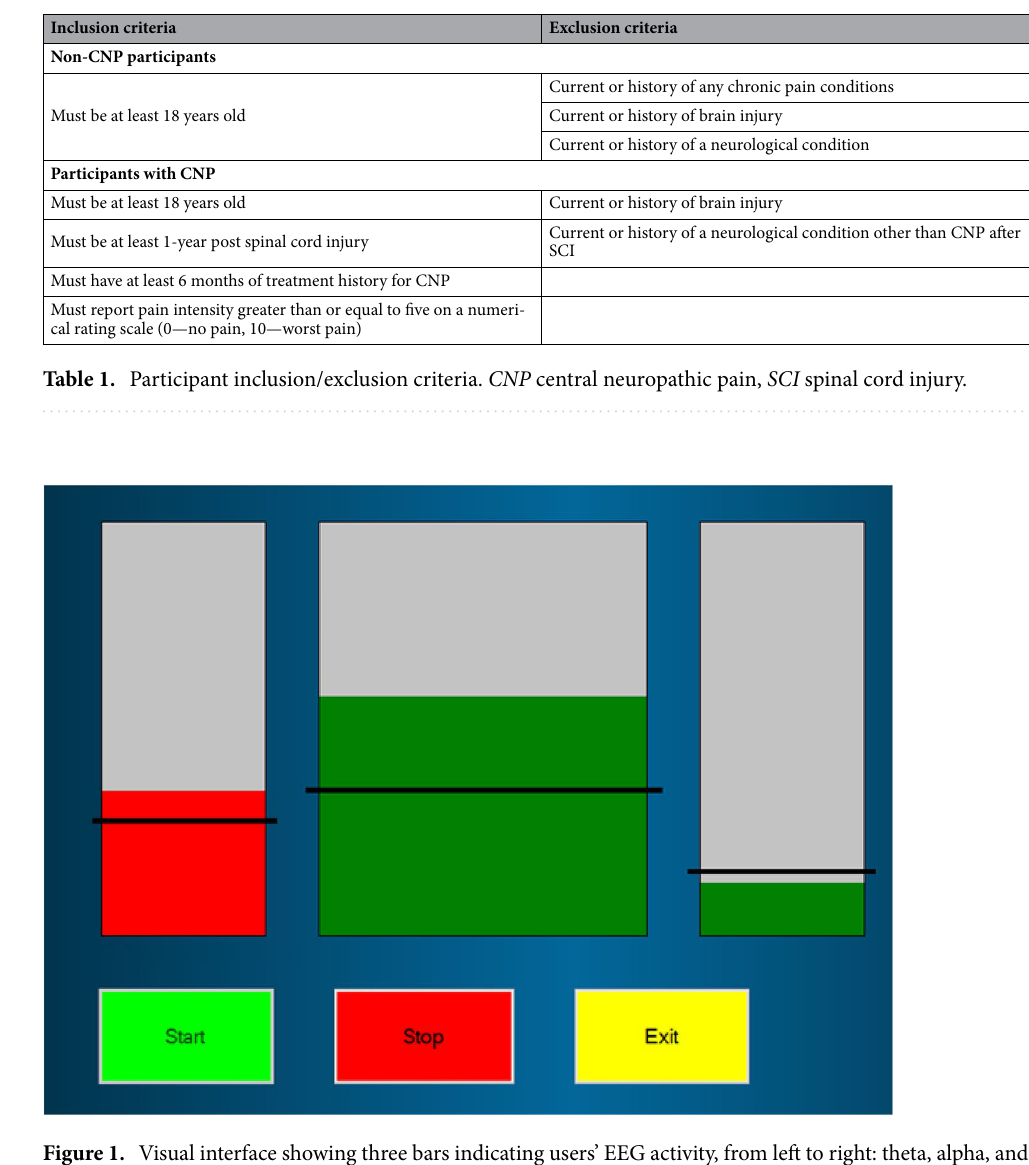
Figure 1. Visual interface showing three bars indicating users’ EEG activity, from left to right: theta, alpha, and higher beta; black lines indicate threshold for illustrative purposes